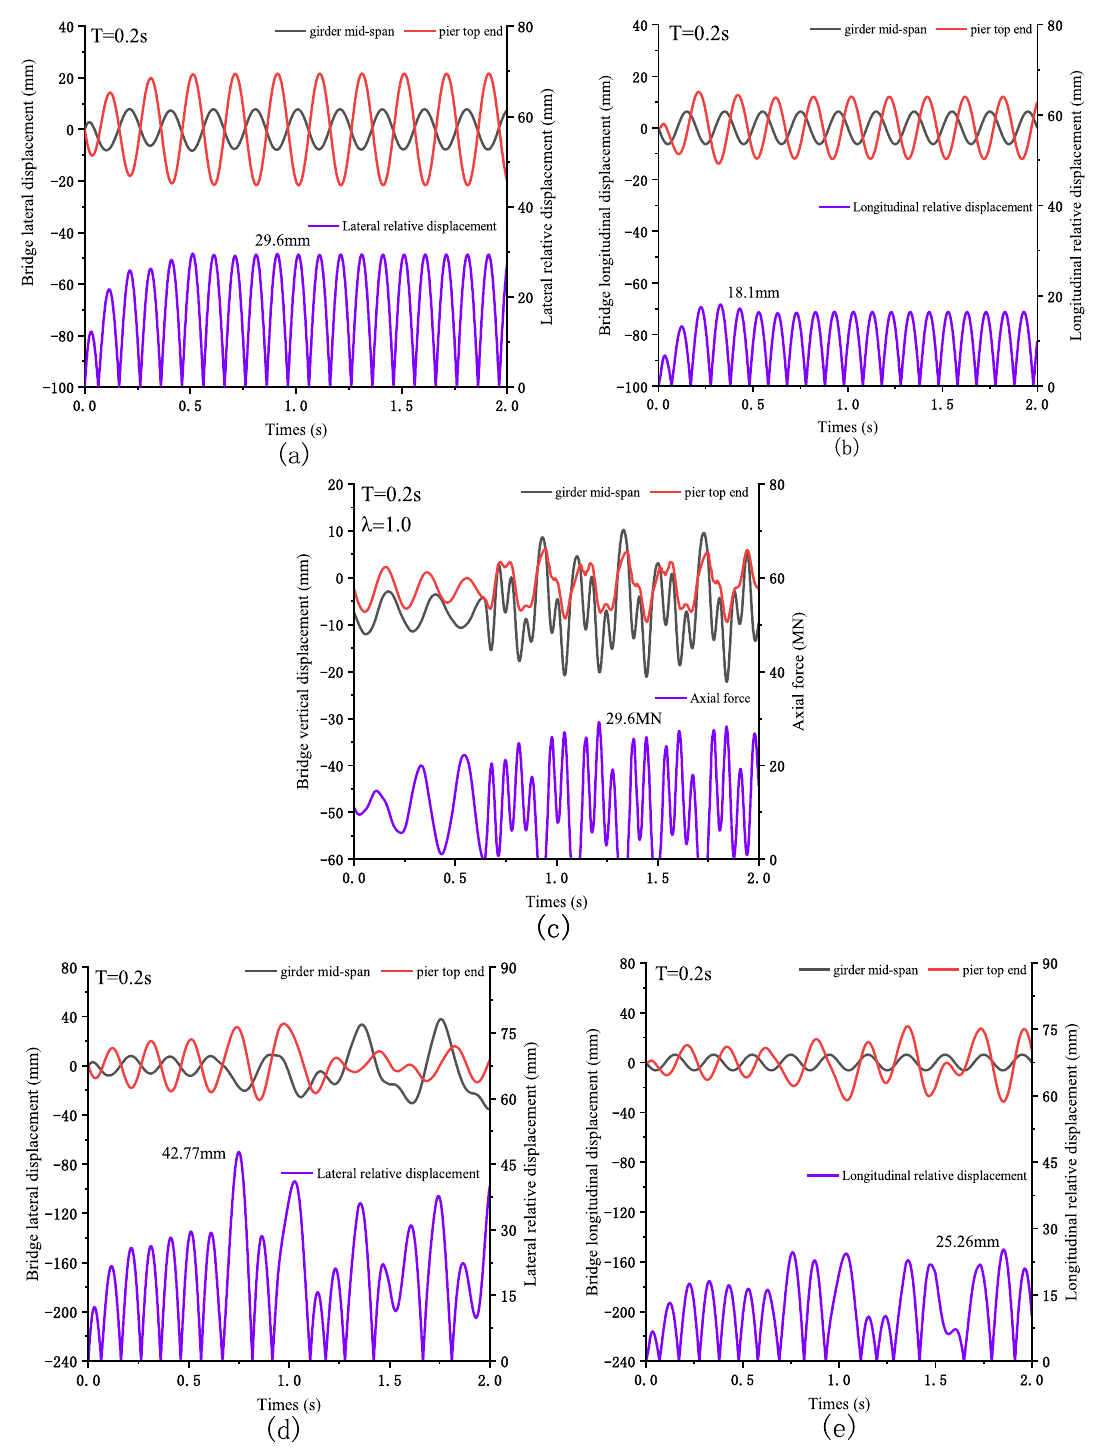
Figure 4. Seismic displacement response of Bridges: ( a ) lateral direction is not separated; ( b ) longitudinal direction is not separated; ( c ) vertical displacement; ( d ) lateral separation occurs; ( e ) longitudinal separation